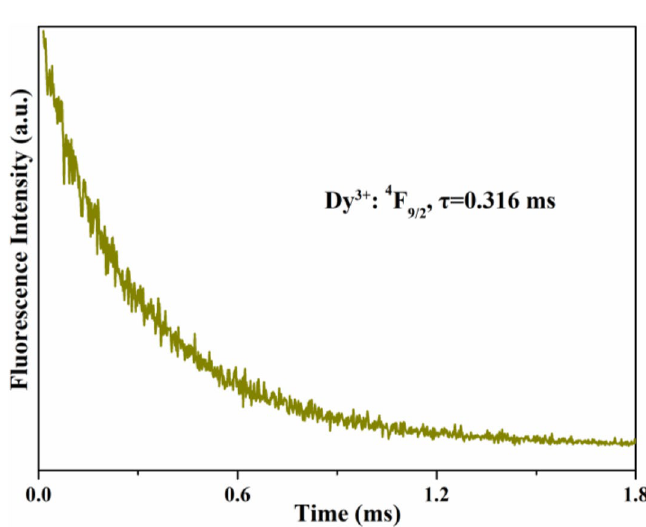
Figure 8. Fluorescence decay curve of the Dy 3+ : 4 F 9/2